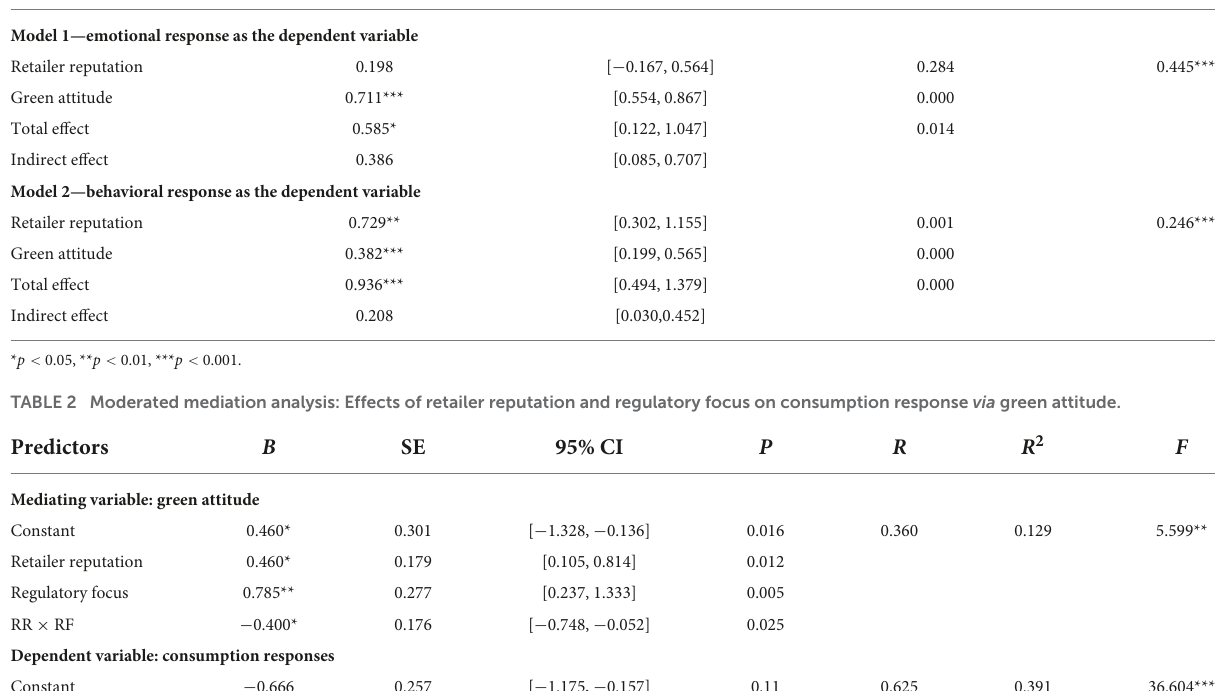
TABLE 1 Results of the mediation analysis with consumption responses as the dependent variables, retailer reputation as the independent variable, and green attitude as the mediator. Predictors B